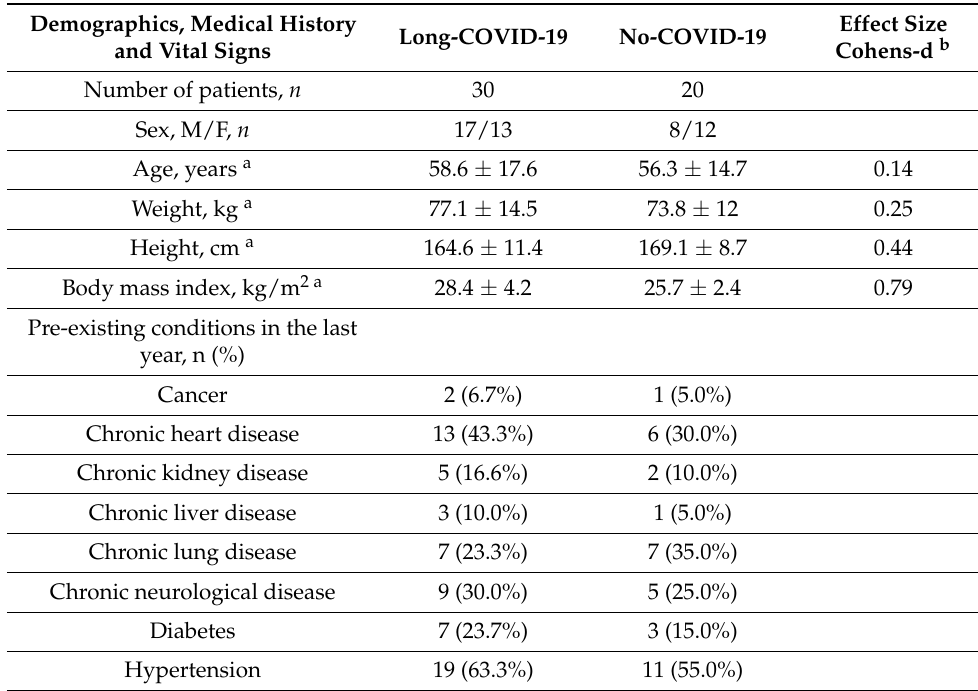
Table 1. Clinical characteristics and baseline values of the study